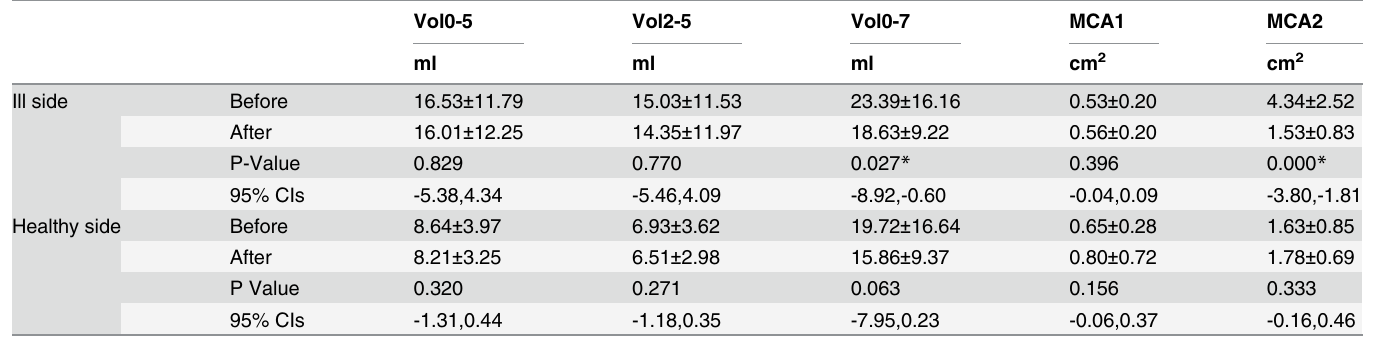
Table 2. The comparison of NV & NMCA before and after obturator placement (n = 26,  x  (cid:2) s ).